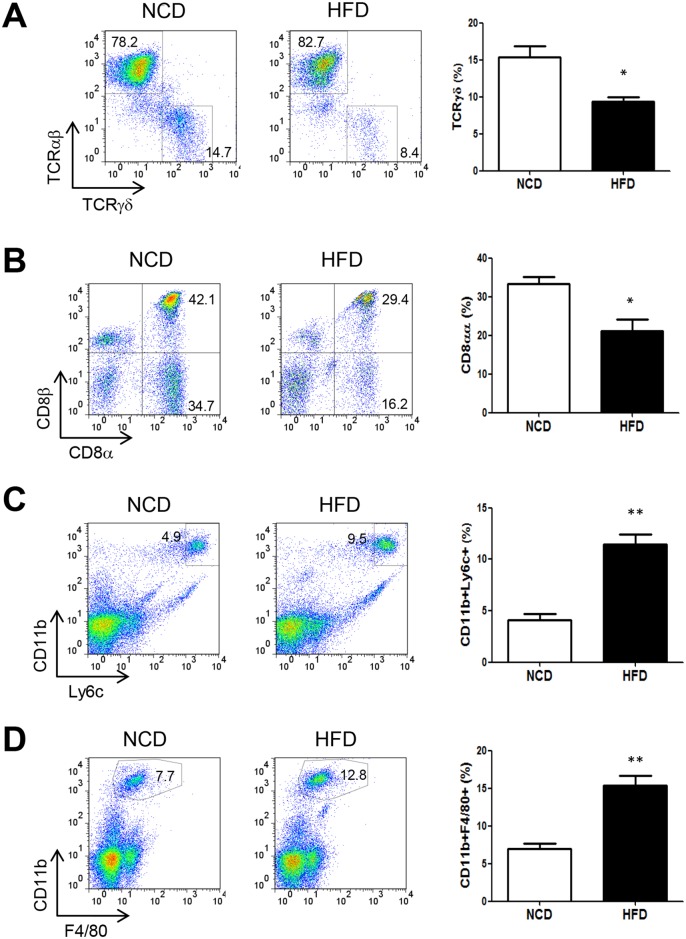
Flow cytometric analysis of cells in the colonic epithelium of high-fat diet (HFD)-fed mice treated with dextran sodium sulfate (DSS).(A and B) Proportions of T cell subsets. Proportions of TCRγδ and TCRαβ cells (A) and those of CD8αα and CD8αβ T cells (B) among colonic intestinal epithelial lymphocytes (IELs) gated on CD3 were determined on day 7 of DSS administration to normal chow diet (NCD) or HFD-fed mice. (C and D) Proportion of myeloid subsets. Proportions of CD11b+Ly6C+ monocytes (C) and CD11b+F4/80+ macrophages (D) in colonic epithelium on day 7 of DSS treatment were determined by flow cytometry. All values are expressed as the means ± SEM. A student’s t-test was used to compare values between two groups. *P < 0.05, **P < 0.01 (n = 5 each).